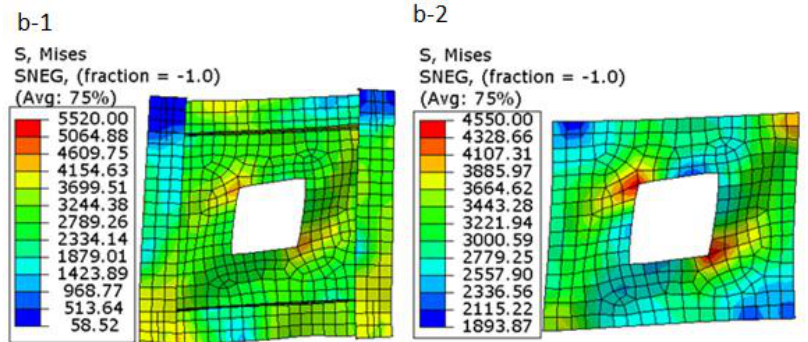
Figure 10. Von Mises stress for shell part (b-1) frame part and (b-2) steel plate.